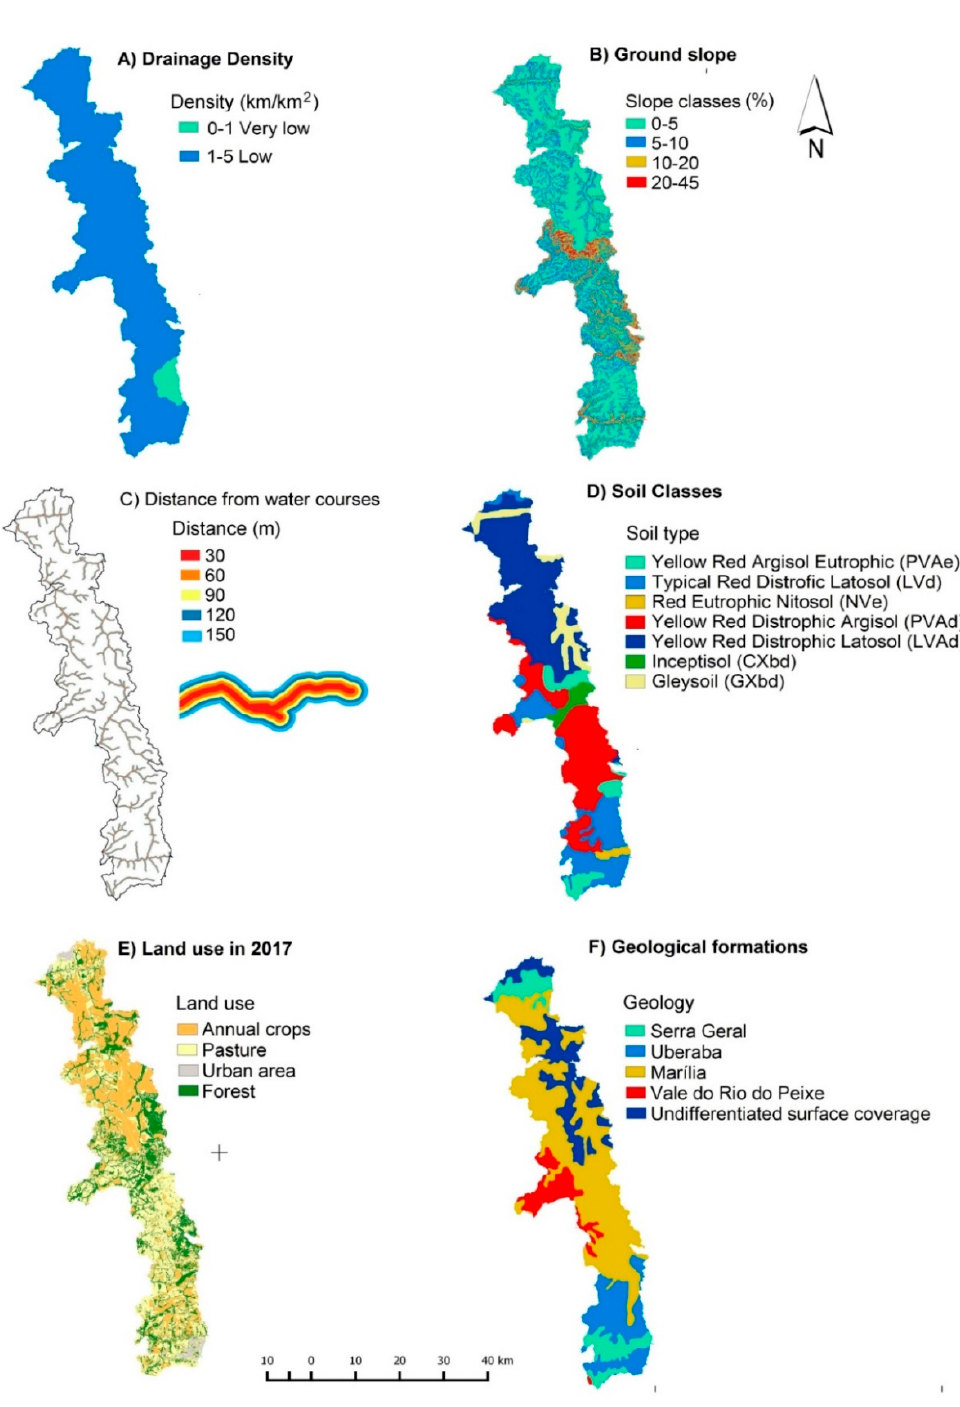
Figure 3. Spatial distribution of vulnerability-relevant factors included in the Multi Criteria Analysis. Adapted from [15].